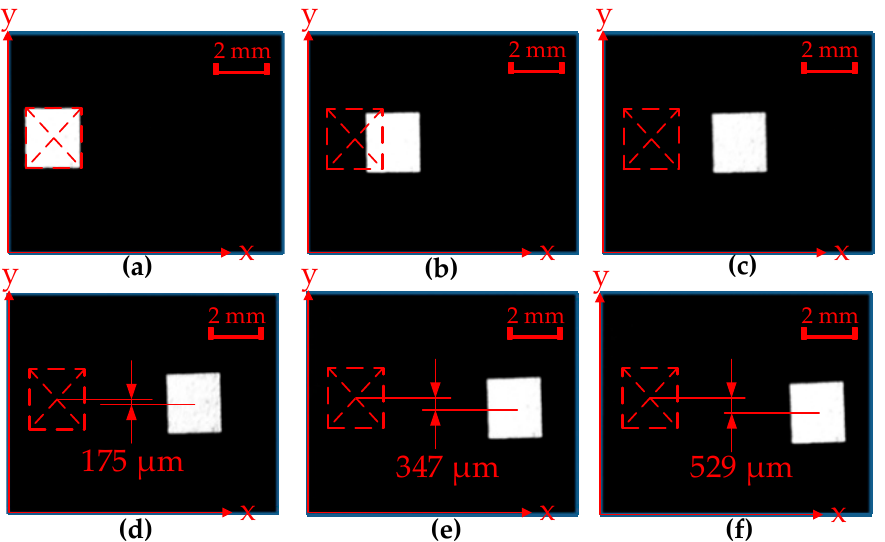
Figure 13. Influence of long displacement conveyance along x ‐ axis.